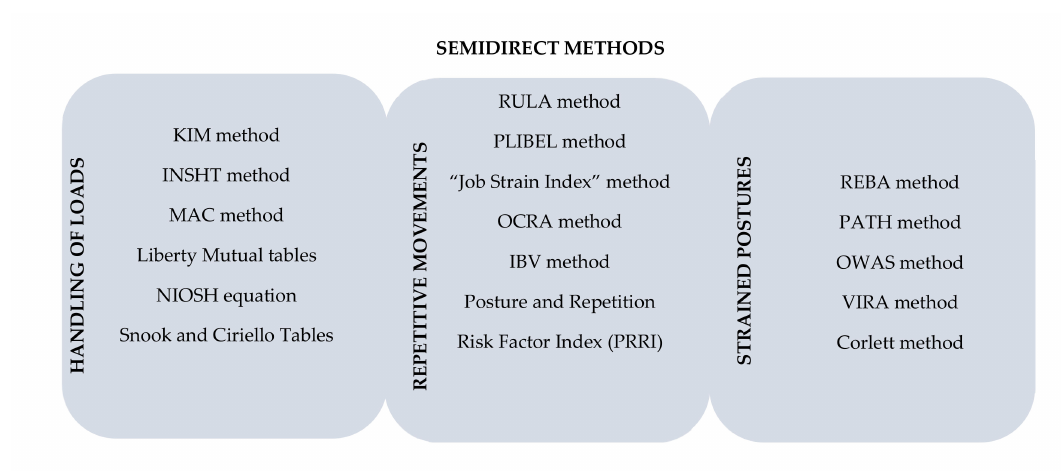
Figure 1. Examples of direct and indirect methods.